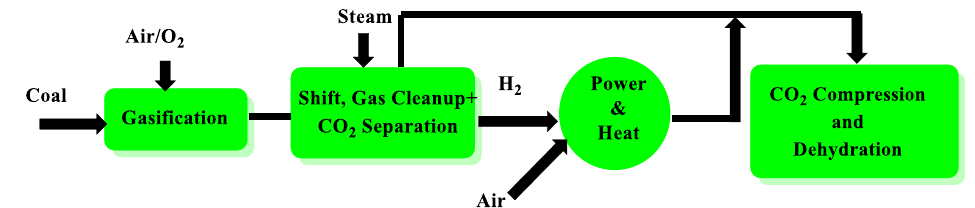
Figure 2. Pre-combustion capture process.